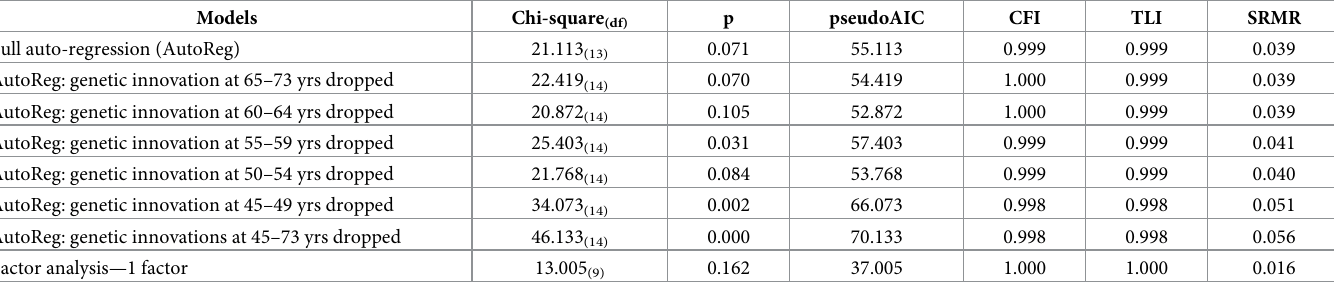
Table 2. Multivariate modeling fitting comparisons based on the combined male & female GWAS summary